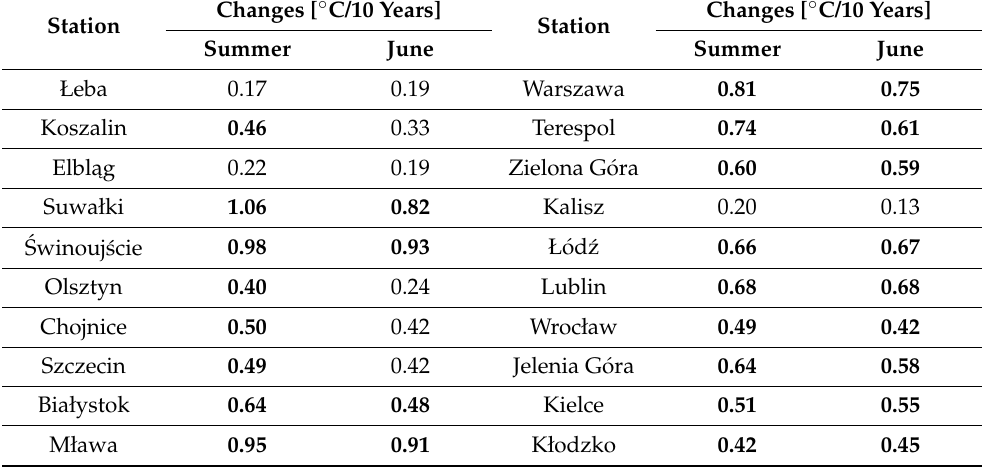
Figure 3. Multi-annual course of mean UTCI in summer in the years 1966–2019 in selected stations. Table 3. Changes of UTCI in summer and June in the years 1966–2019. Stations are arranged in spatial order from the north to the south.